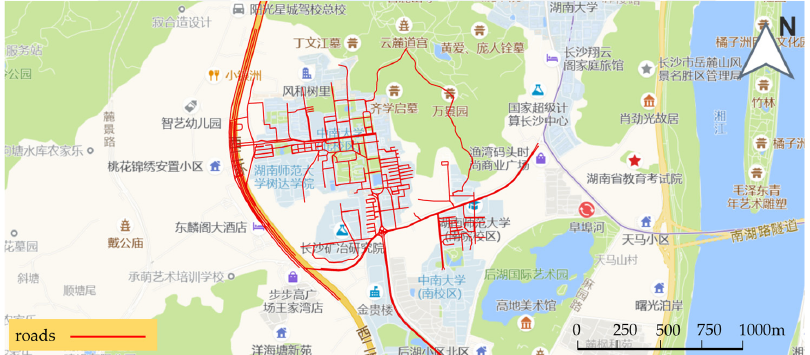
Figure 9. Registration result of the vector data.